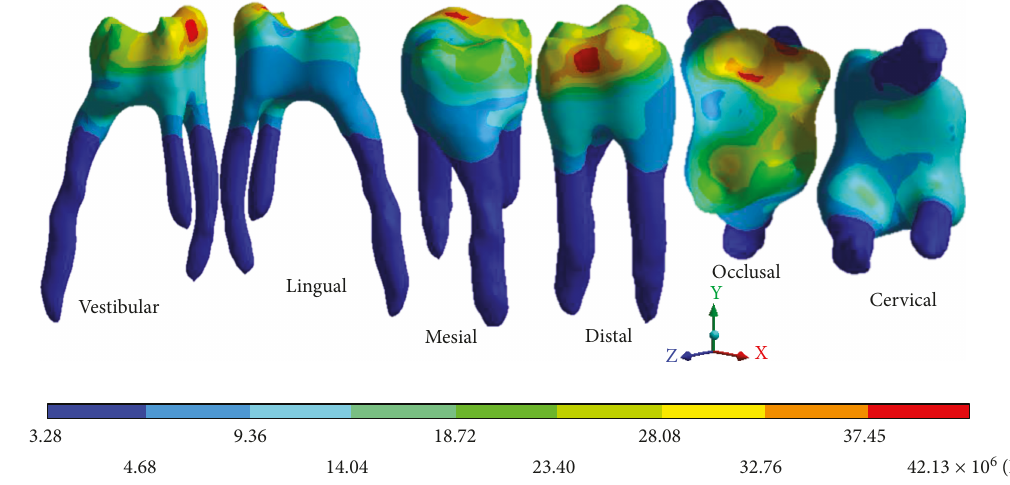
Figure 14: 2nd degree caries : von Mises stresses in